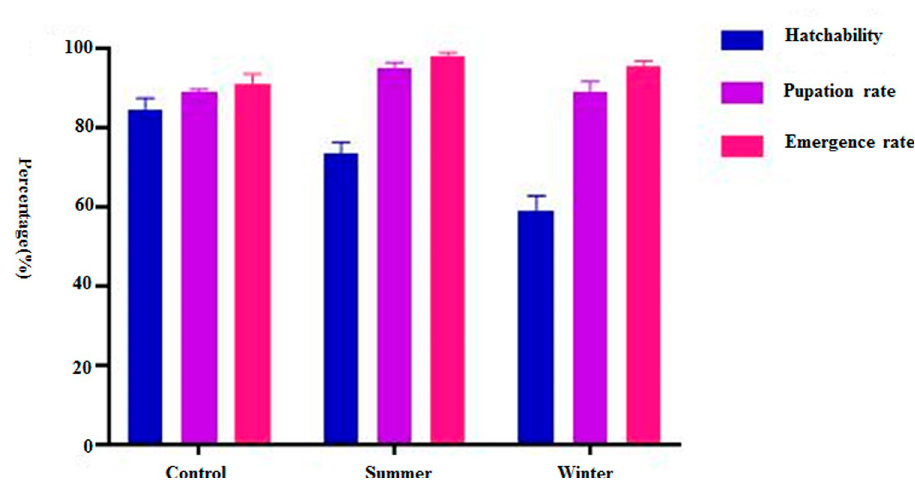
Fig 2. Hatching rate, pupation rate, and emergence rate of Ae . albopictus under different environmental conditions.